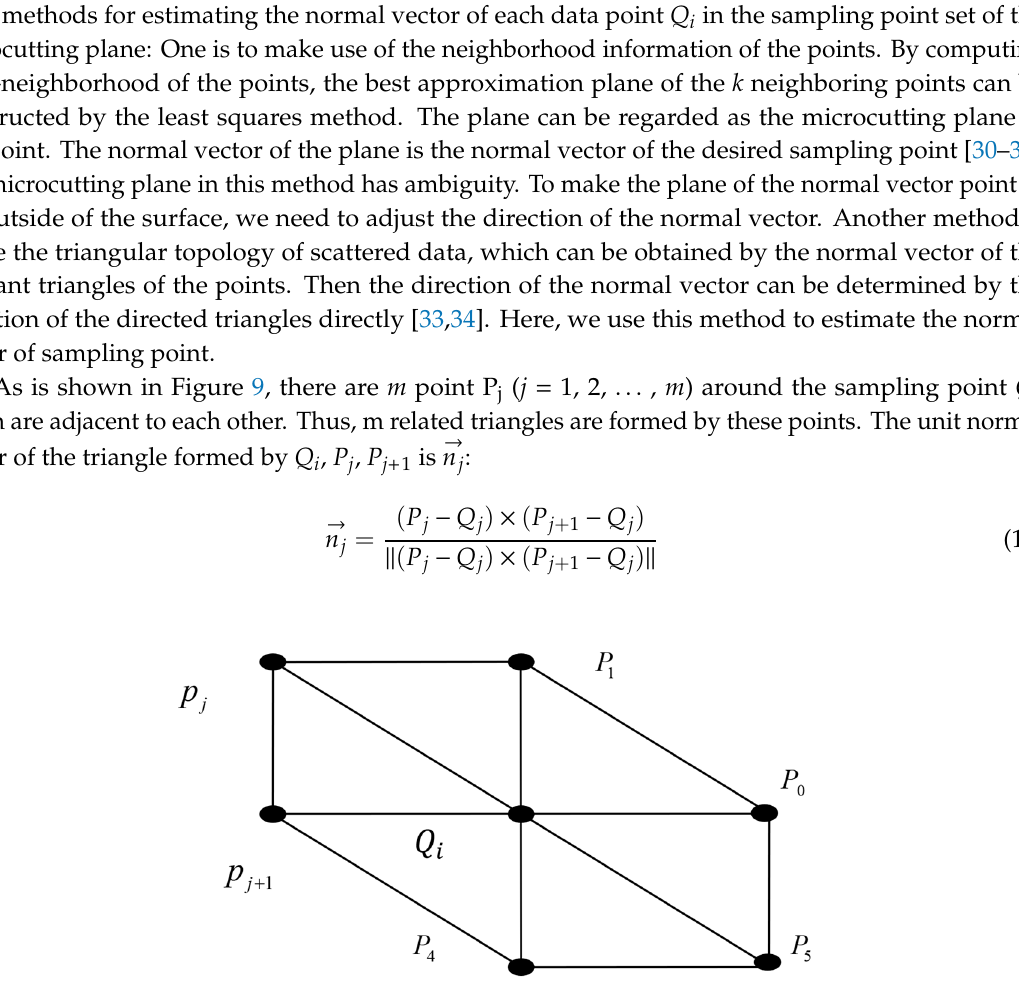
Figure 9. Estimation of normal vector of point 𝑄𝑖 .